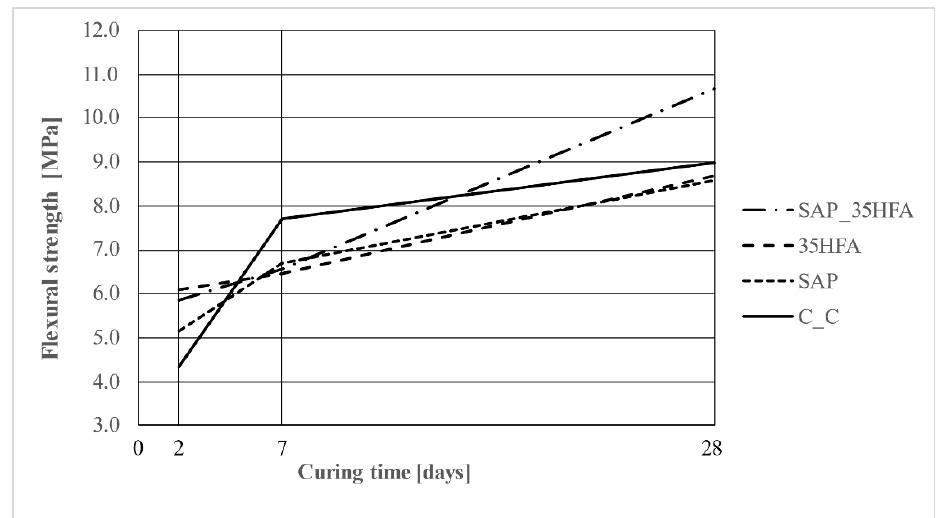
Figure 19. Flexural strength after 2, 7 and 28 days of curing.